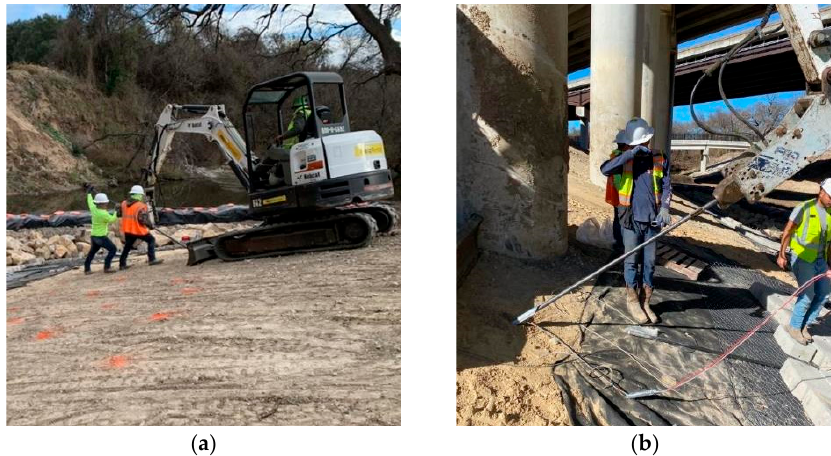
Figure 9. PDEA anchor driving process on west bank slope using mini-excavator: ( a ) setup of a mini excavator and ( b ) anchor driven using the excavator.